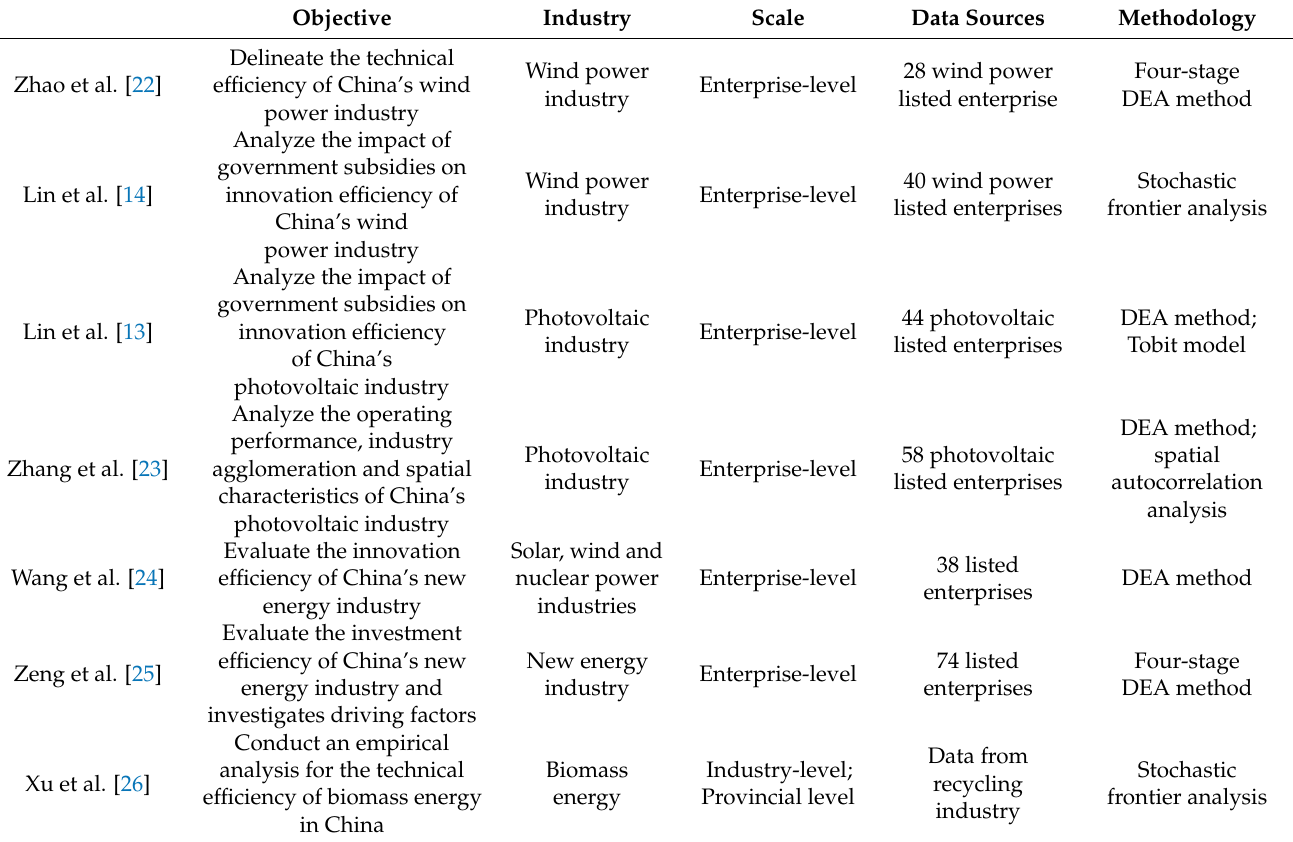
Table 1. Previous research on the efficiency of China’s new energy